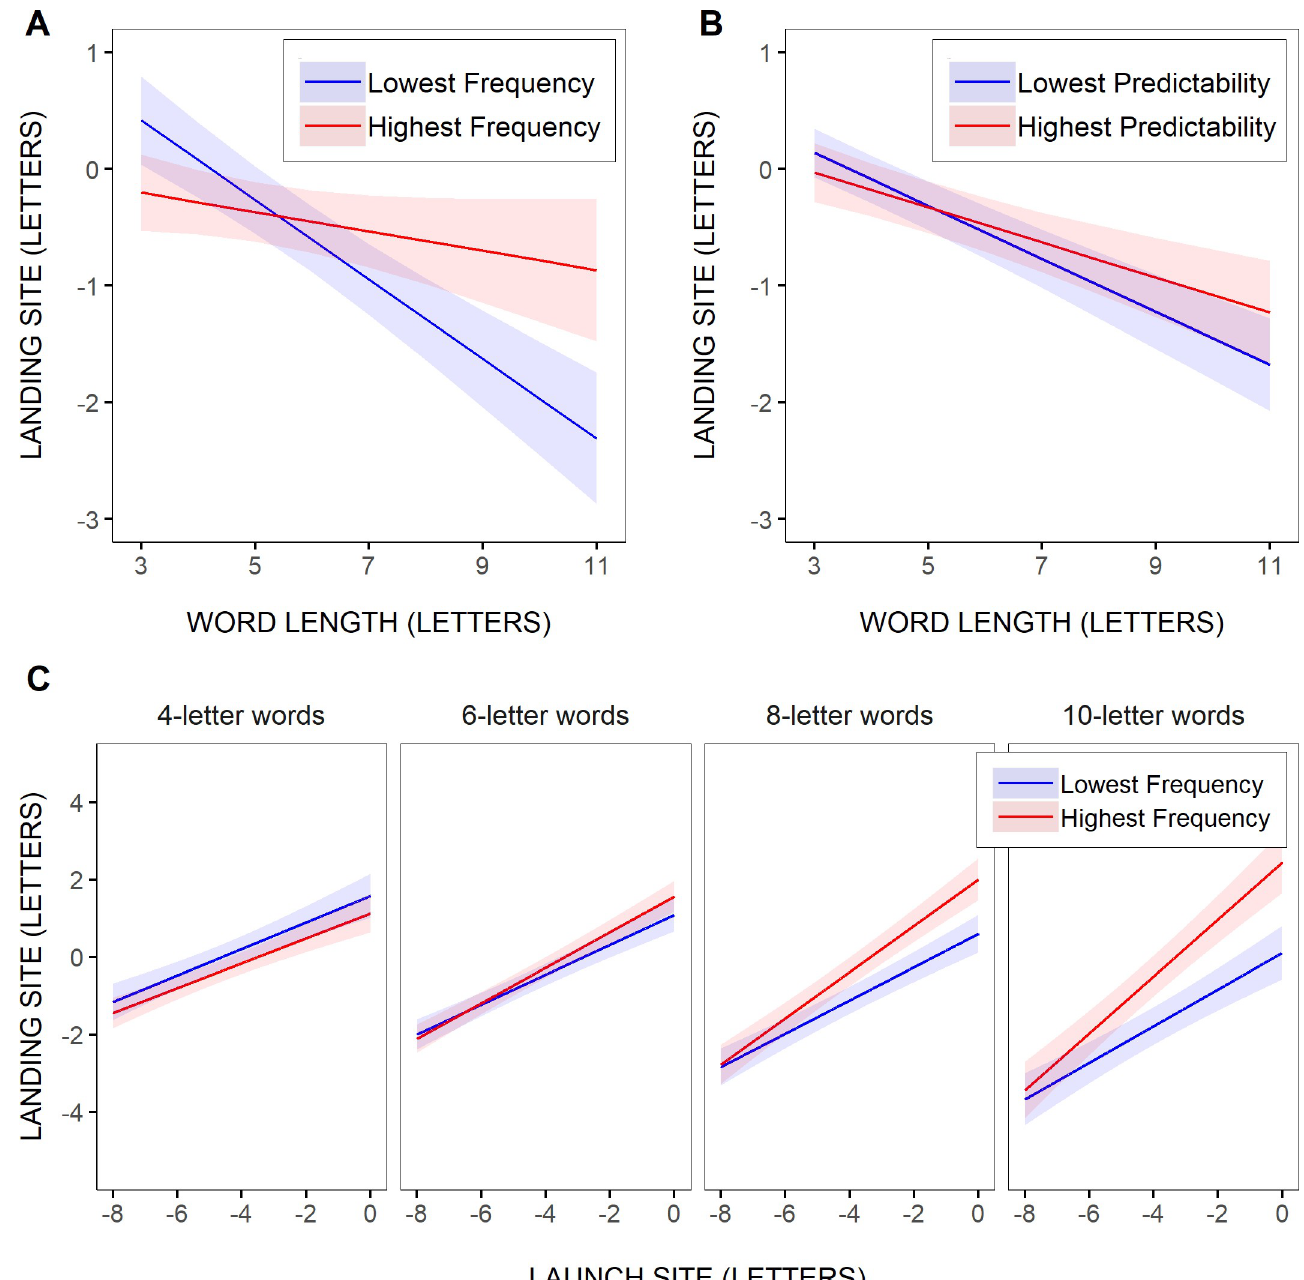
Fig 8. Estimated initial landing positions in the test words. Partial effects (with 95% confidence intervals) computed from LMM parameters (Table 6), representing initial landing positions in the test words as a function of word length (in letters; A-B), and for 4-,6-,8-, and 10-letter test words as a function of saccadic launch-site distance (in letters relative to the space in front of the test words; C), separately for the two most extreme word-frequency values across all test words (-1.97 vs. 7.16 log units; A,C), and the two most extreme word-predictability values across all test words (-2.60 vs. 2.60 logit units;